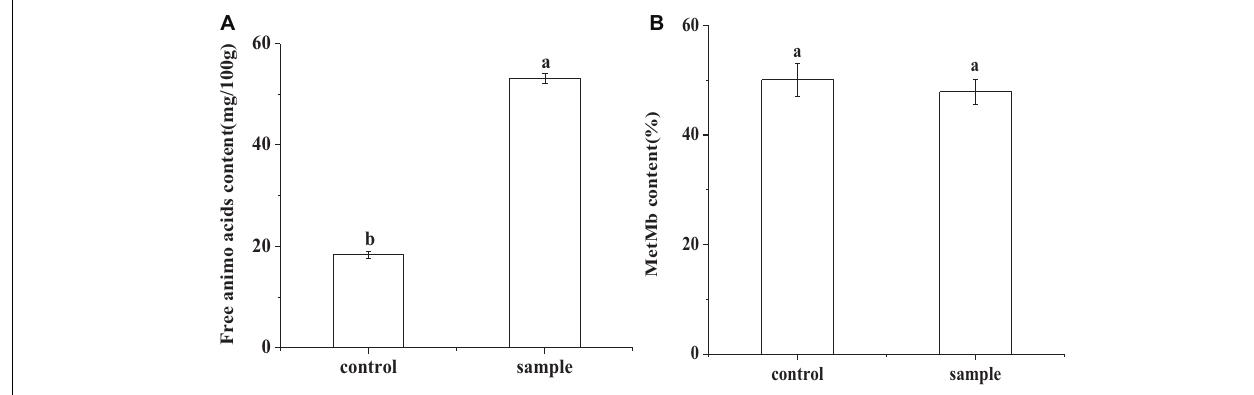
FIGURE 5 | The free amino acid content (A) and the Met-Mb content (B) of the sausages at the end of ripening period, in which different lowercase letters meant that amino acid content or Met-Mb content was significantly different ( p < 0.05).